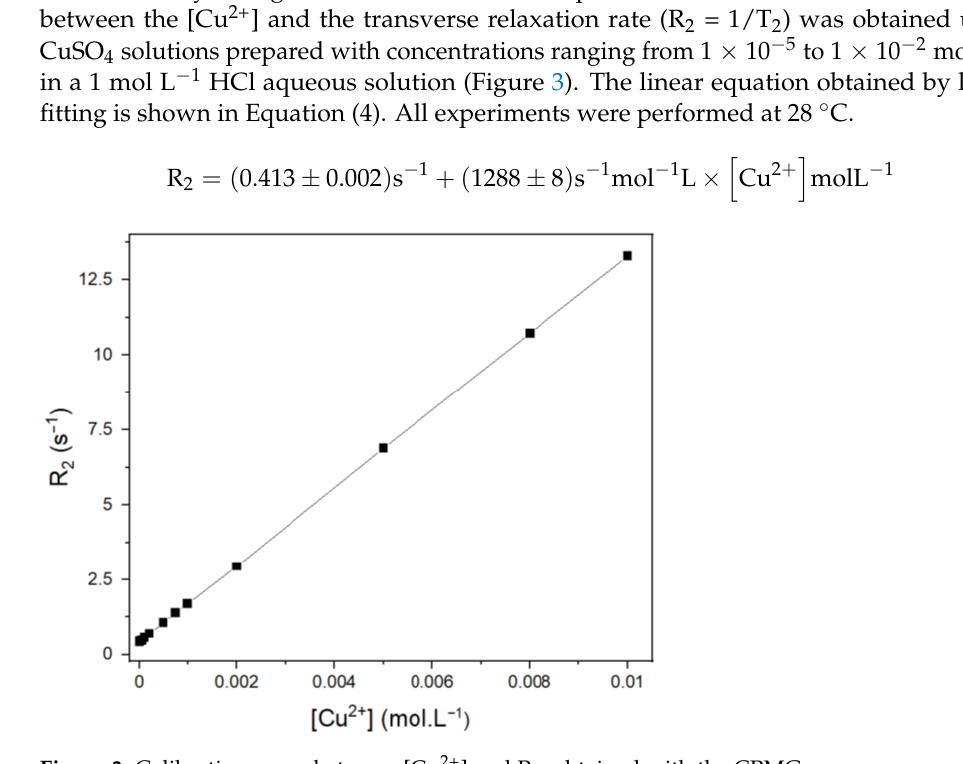
Figure 3. Calibration curve between [Cu 2+ ] and R 2 , obtained with the CPMG